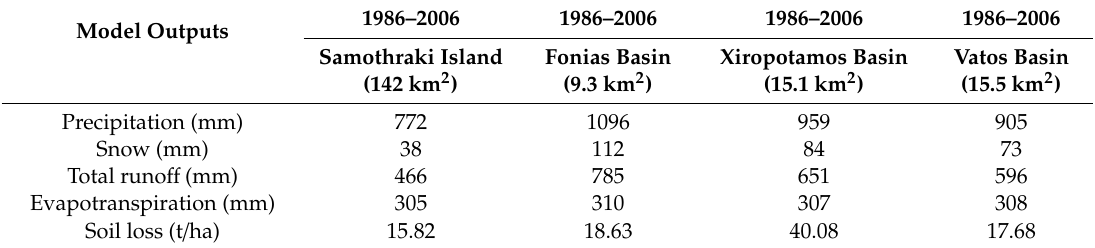
Table 3. Simulated water balance components (mm) and soil loss (t / ha) on a mean annual basis. Model Outputs Model Outputs